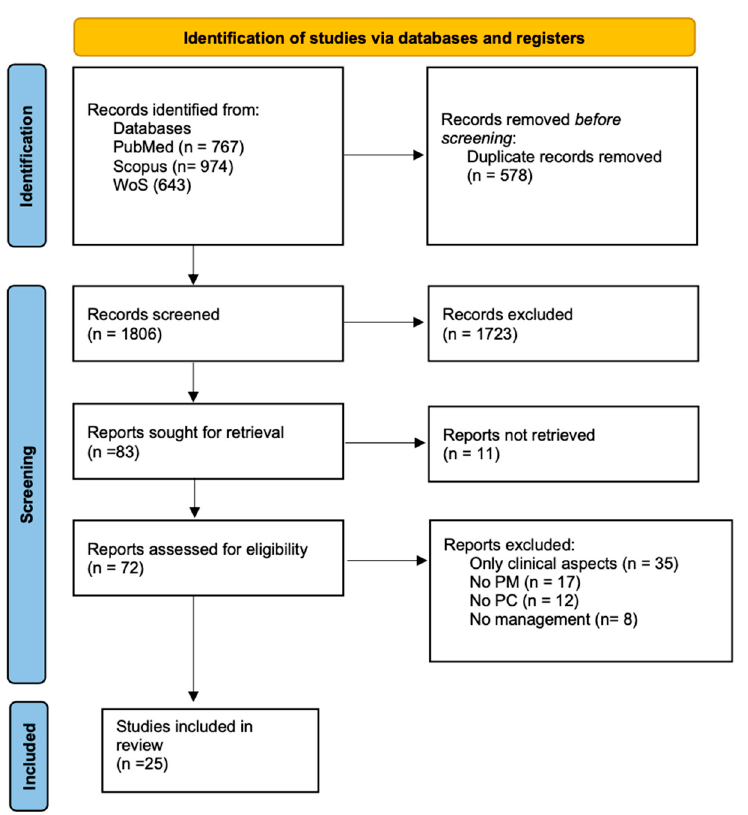
Figure 1. PRISMA Flowchart of the literature review and selection process for breast cancer manage- ment in terms of patient-centered care and personalized medicine approaches.